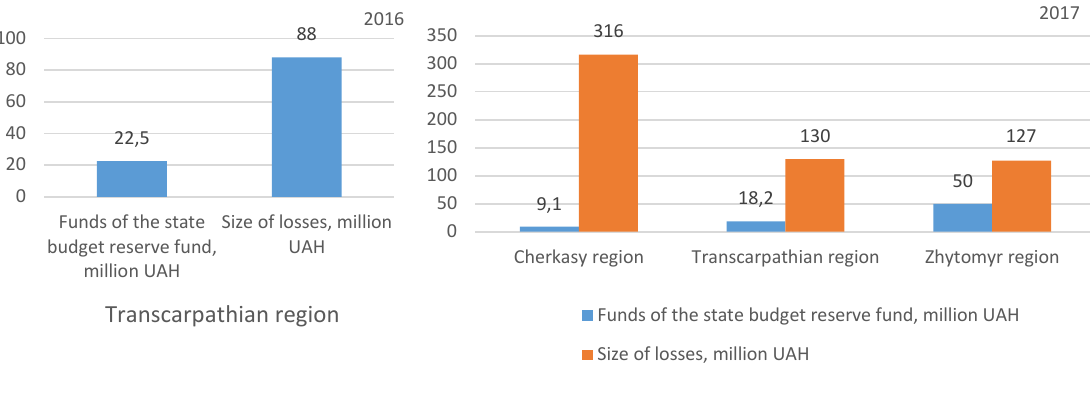
Figure 2. The size of losses and funds of the state budget reserve fund for measures to eliminate the consequences of natural calamities in the regional context in 2016–2017